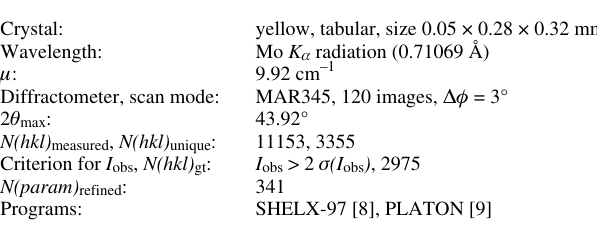
Table 1. Data collection and